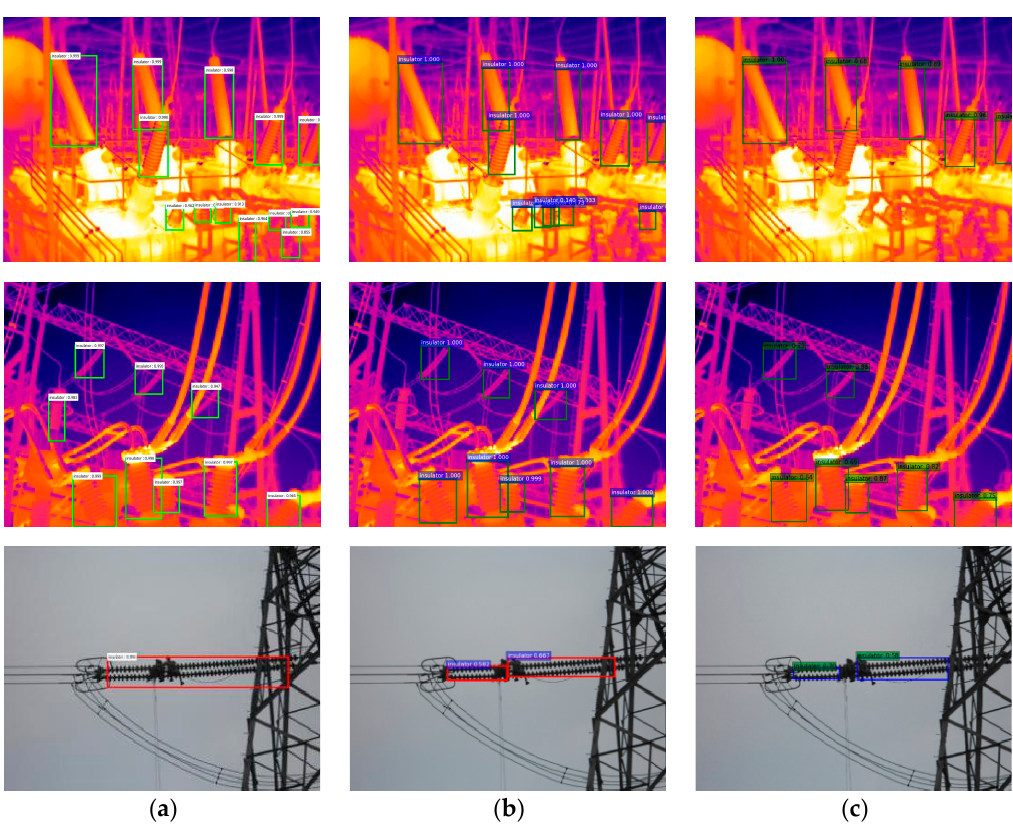
Figure 12. The detection results of our method, and the R-FCN and SSD methods. ( a ) Proposed method; ( b ) R-FCN; ( c ) SSD.